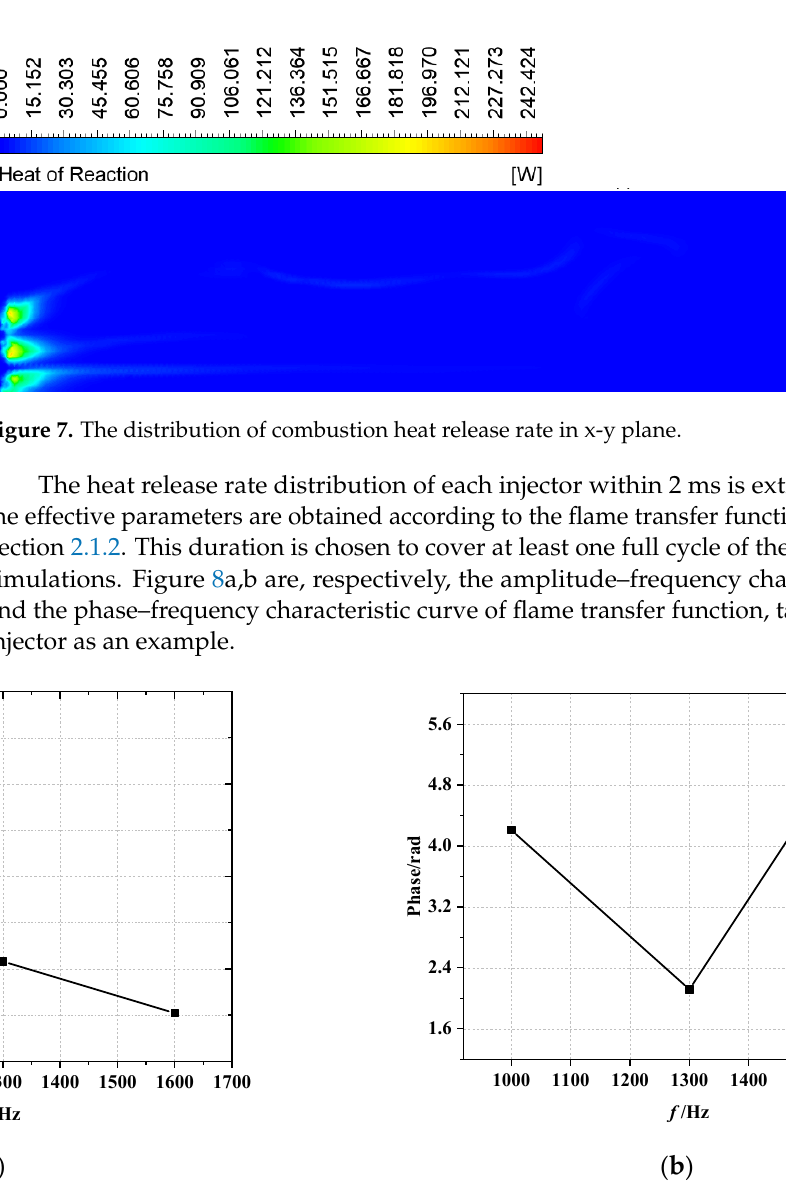
Figure 8. Central injector flame transfer function. ( a ) Amplitude–frequency curve. ( b ) Phase– frequency